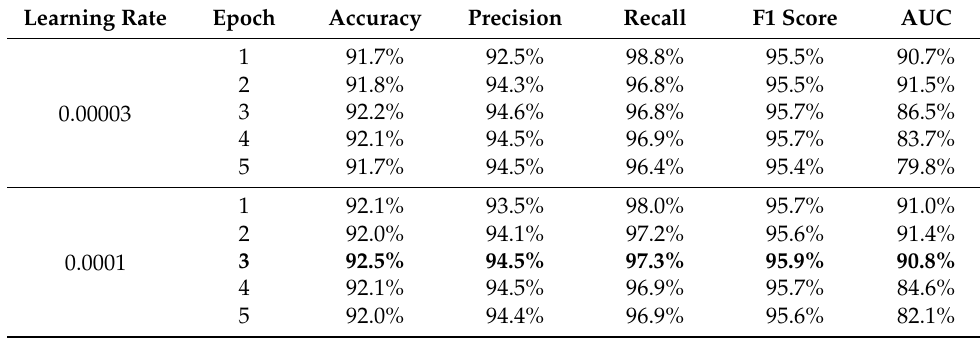
Table 2. Performance of the BERT models on the development set.